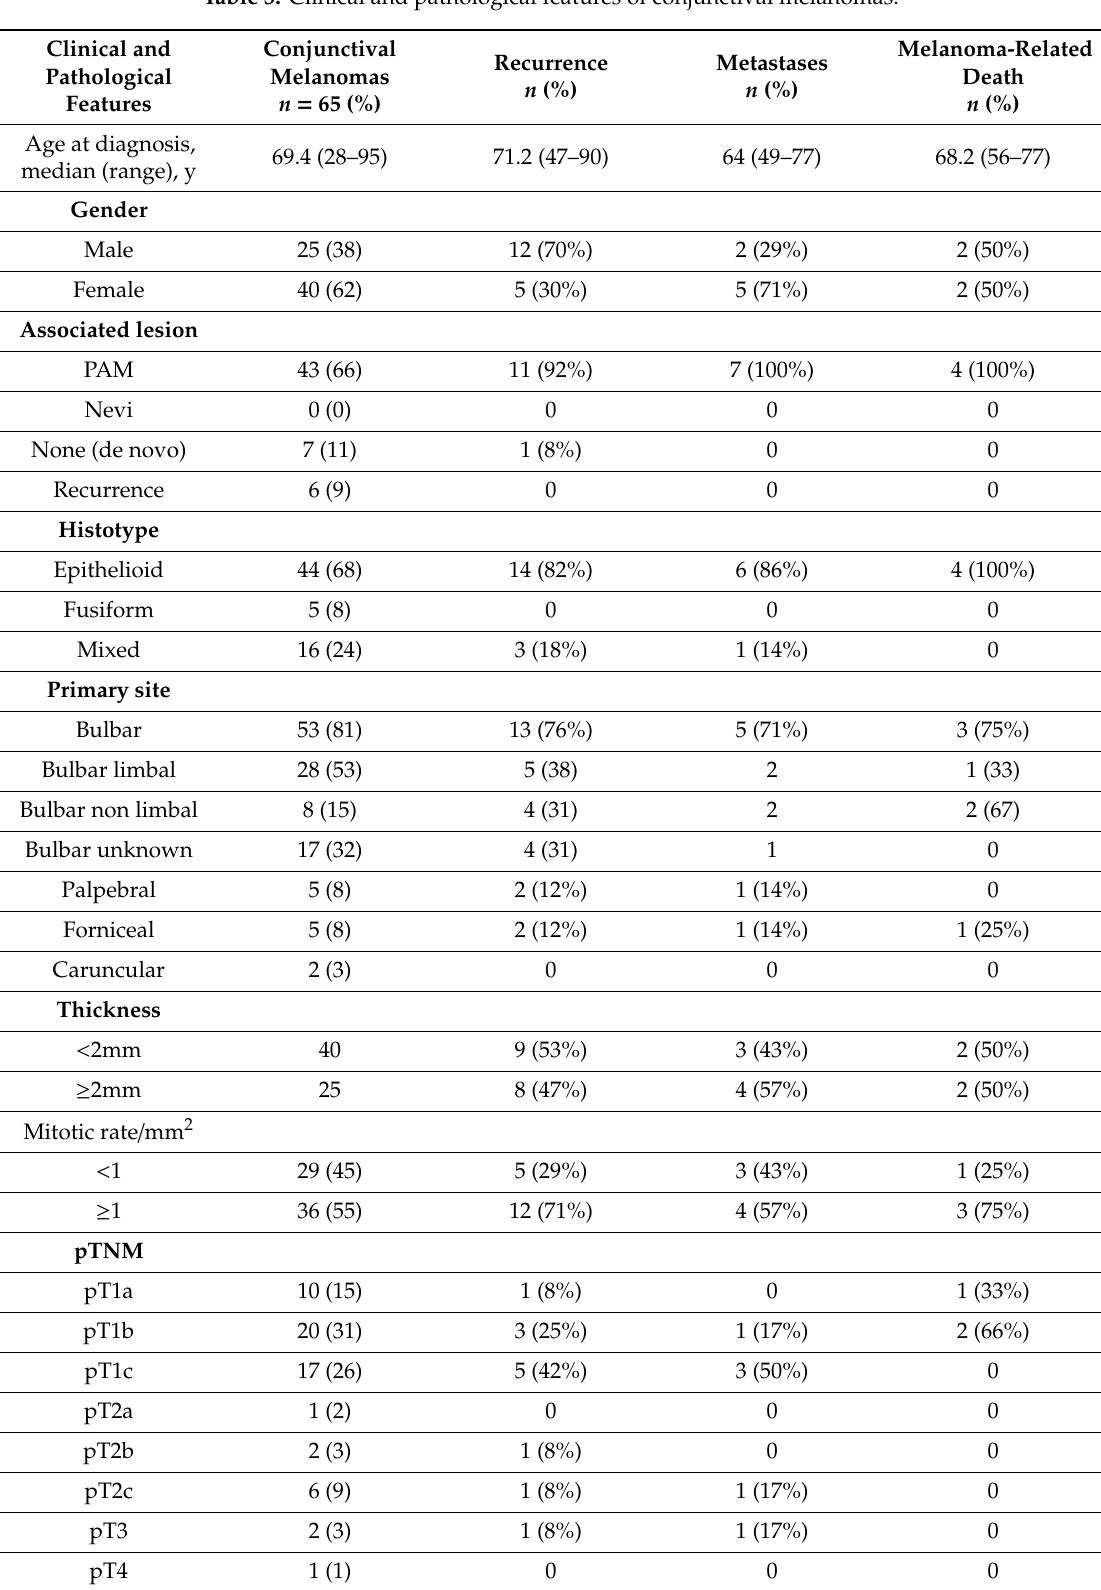
Table 3. Clinical and pathological features of conjunctival